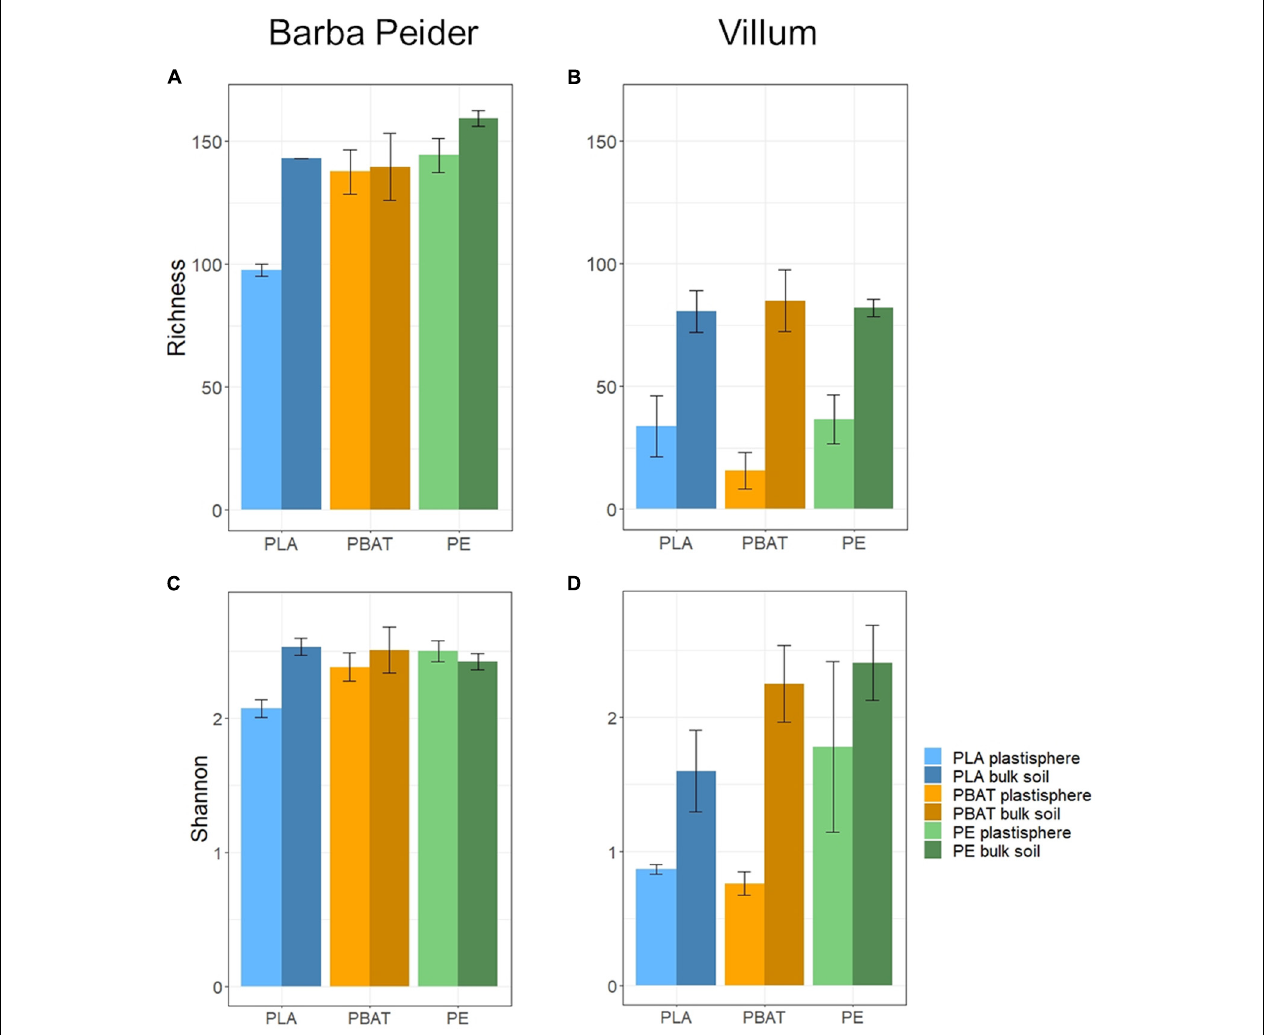
FIGURE 2 | Fungal α -diversity (mean ± sd; n = 3) of plastisphere and bulk soil samples showing observed richness (A,B) and Shannon Index (C,D) in Barba Peider (Swiss Alps) (A,C) and Villum (Northern Greenland) (B,D)